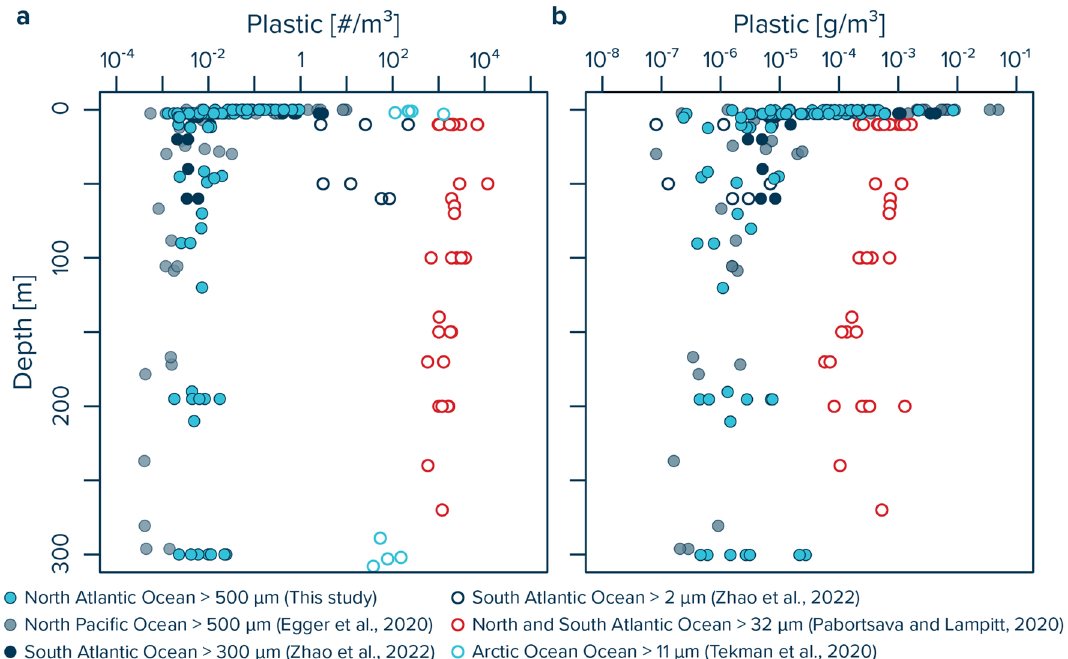
Figure 6. Comparison of ( a ) numerical and ( b ) mass concentrations of plastic debris of different sizes measured in the upper 300 m of ocean water column in this and other studies. Numerical concentrations of larger microplastics (> 100 µm) collected by underwater trawls 43,50 can be up to 7 orders of magnitude lower than numerical concentrations of small microplastics (< 100 µm) collected by in-situ pumps 48–50 . Mass concentrations of small microplastics (< 100 µm) show a large range, varying by up to 5 orders of magnitude between two studies in the Atlantic Ocean 48,50